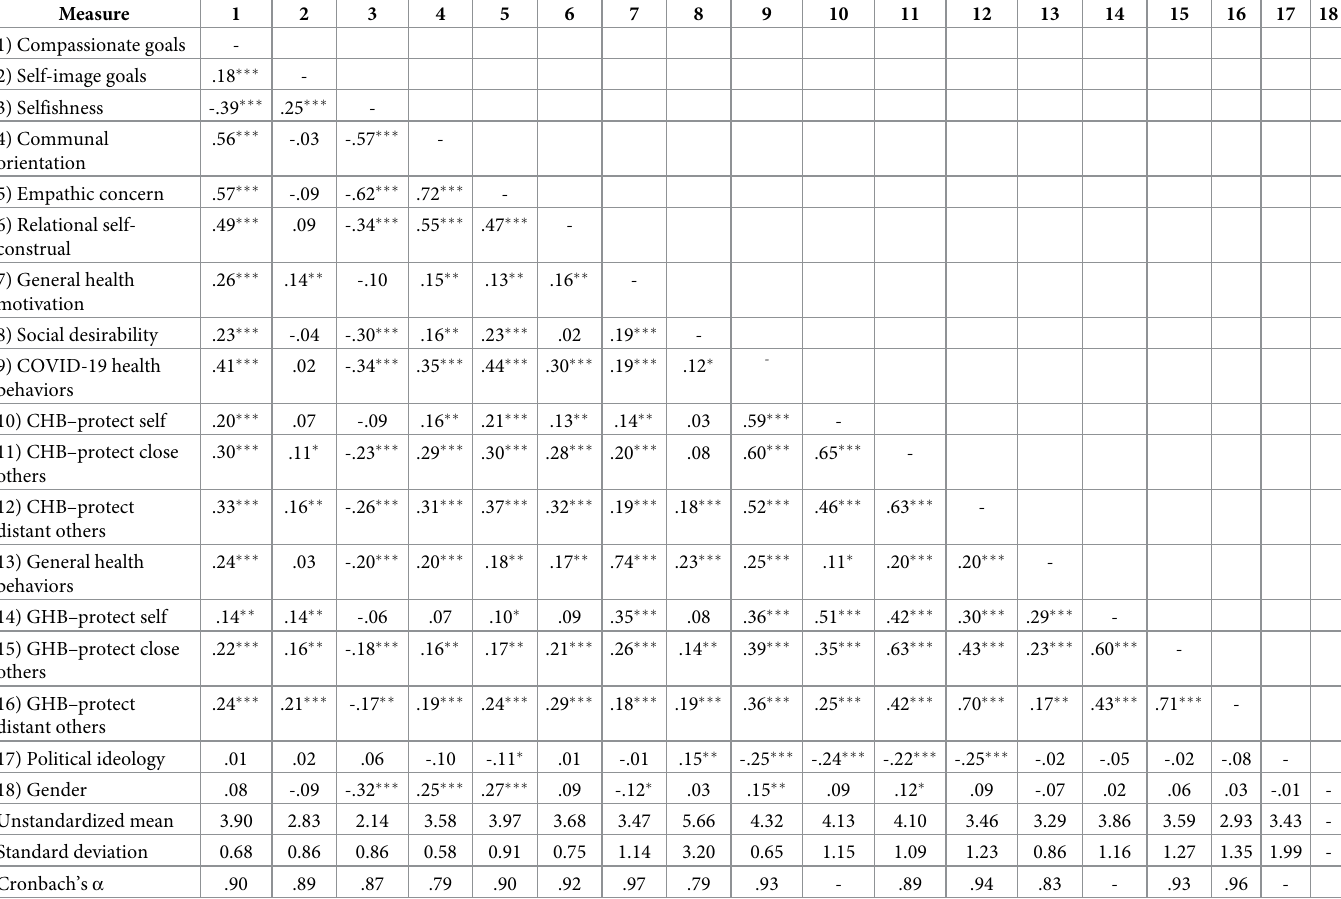
Table 9. Descriptive statistics and zero-order correlations in Study 3.